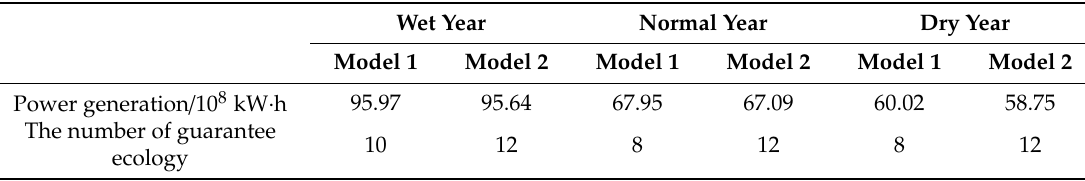
Table 4. Analysis of power generation and ecological guarantee in each typical year.